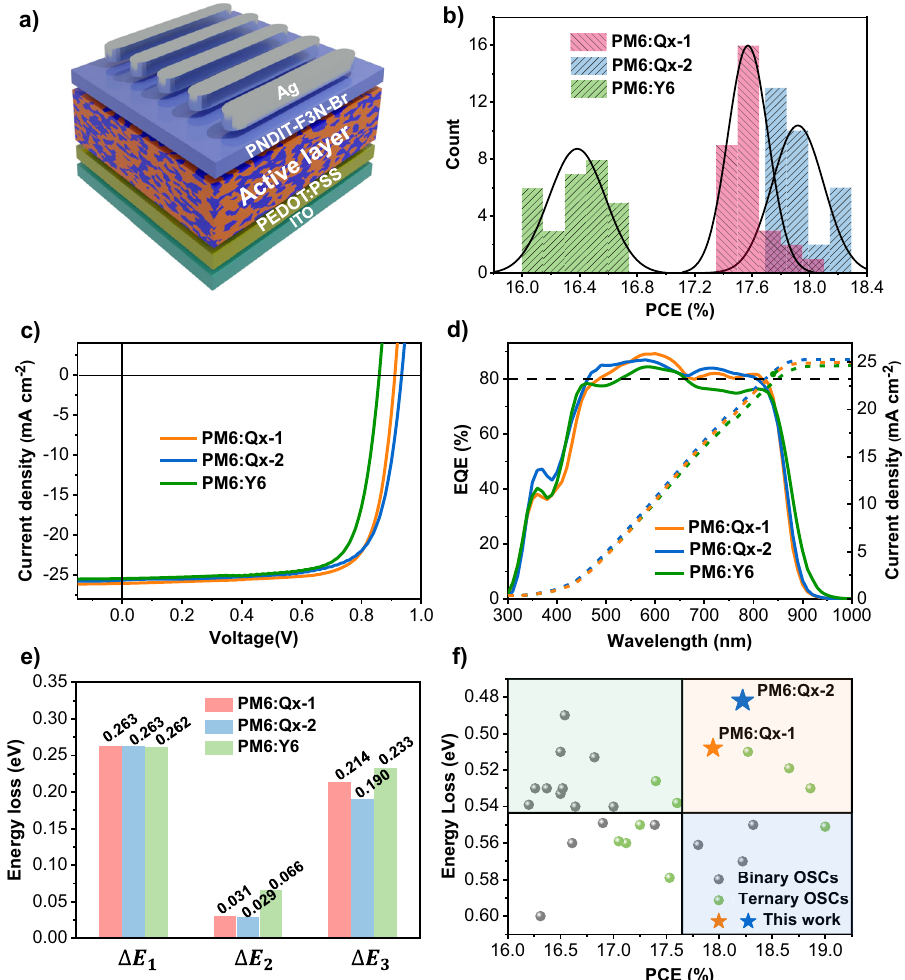
Fig. 3 Photovoltaic performance and energy loss of Qx-1, Qx-2, and Y6 with PM6 as the donor. a The conventional device architecture. b Statistics distribution of best PCE for ca .30 pieces. c The density – voltage ( J – V ) curves. d The external quantum ef fi ciency (EQE) spectra and the integrated current densities from the EQE spectra of the optimal device. e Statistical diagram of energy loss. f Plots of the PCE against energy loss for various systems. Table 1 Photovoltaic parameters of OSCs with the donor PM6.